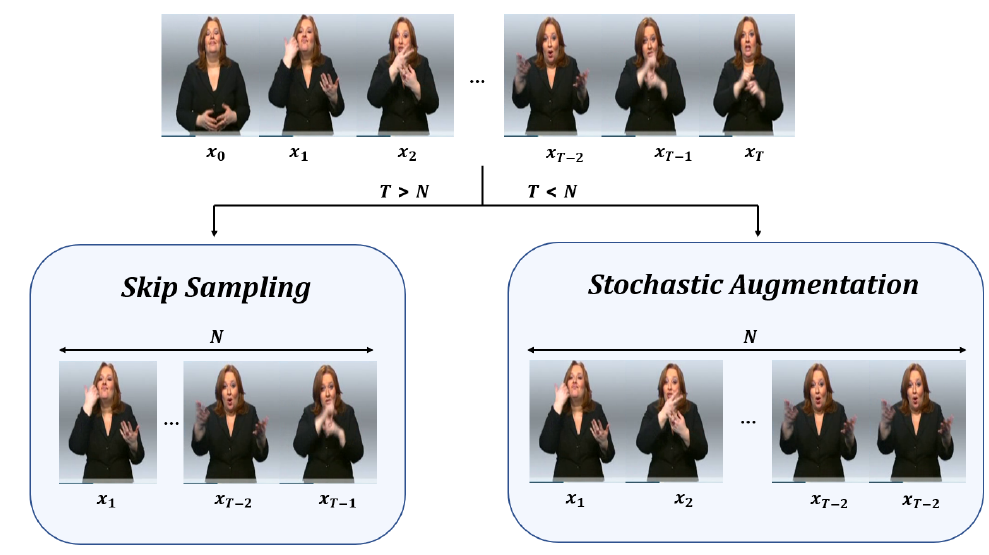
Figure 4. An overview of SASS. This is our frame selection method. If the length T of the video frame is less than a fixed scalar N , a stochastic augmentation method is used, and if T is greater than N , skip sampling is used to match T with the number of N